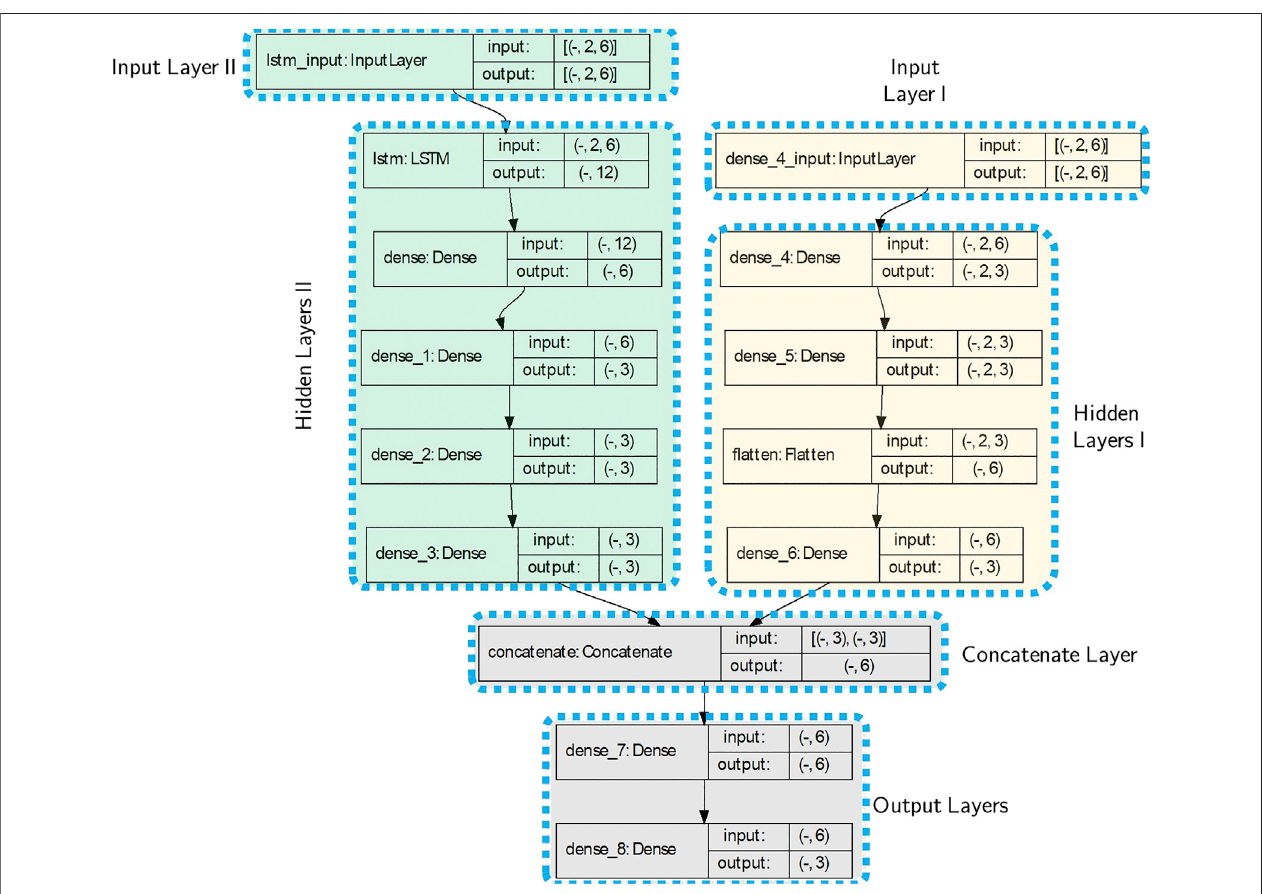
FIGURE 11 | The model architecture used for the experiment. There are two Input layers, the fi rst one is the poses of the node and the second input is the applied forces on the proximal node. The fi rst dimension of inputs and outputs in each layer are unspeci fi ed, and can vary with the size of batches.